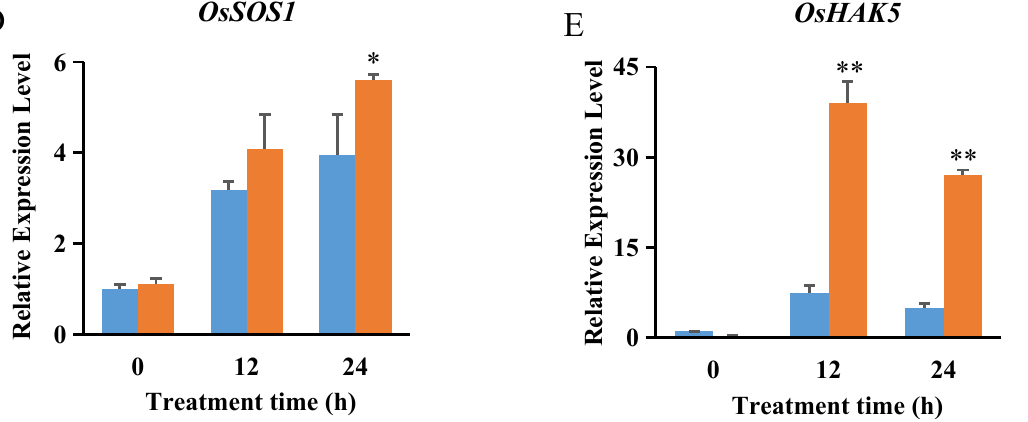
Figure 3. Overexpression of OsABT regulates Na + and K + levels under salt stress. ( A – C ) Na + content, K + content, and K + /Na + ratio in the roots of two–week–old OsABT–OE lines (OE–3 and OE–4) and wild type (WT) plants exposed to salt stress (200 mM NaCl) for 0, 12, and 24 h. ( D , E ) Expression of OsSOS1 and OsHAK5 in the roots of two–week–old OsABT–OE line (OE–3) and WT plants. Root RNA was isolated and used for quantitative real–time polymerase chain reaction (qRT–PCR). Actin was used as an internal control. The relative expression levels were represented by fold change relative to the expression of WT before salt treatment (0 h). Data are means ± SD of three independent experiments. Asterisks indicate significant differences compared to WT plants at * p < 0.05 and ** p < 0.01 (Student’s t − test).